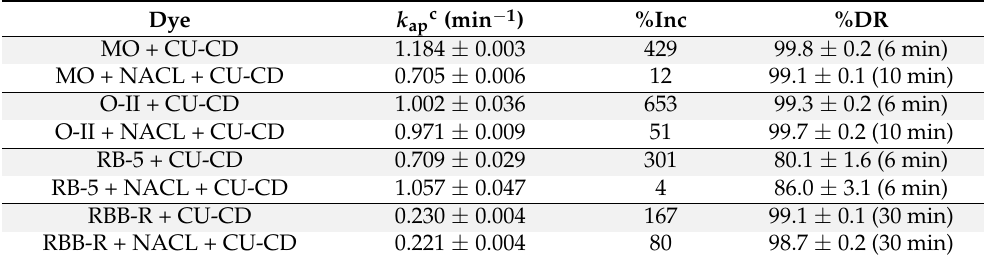
Table 2. Apparent constant rate and percentage of dye removal of the ozonation AOP in the presence of Cu-CD (the standard deviation of at least three independent repetitions is shown). The number of times the k ap increased relative to the uncatalyzed reaction (Table 1) and the reaction time necessary to achieve the percentage of dye removal is shown in parentheses. Fitting of the integrated first-order kinetics resulted in R 2 >